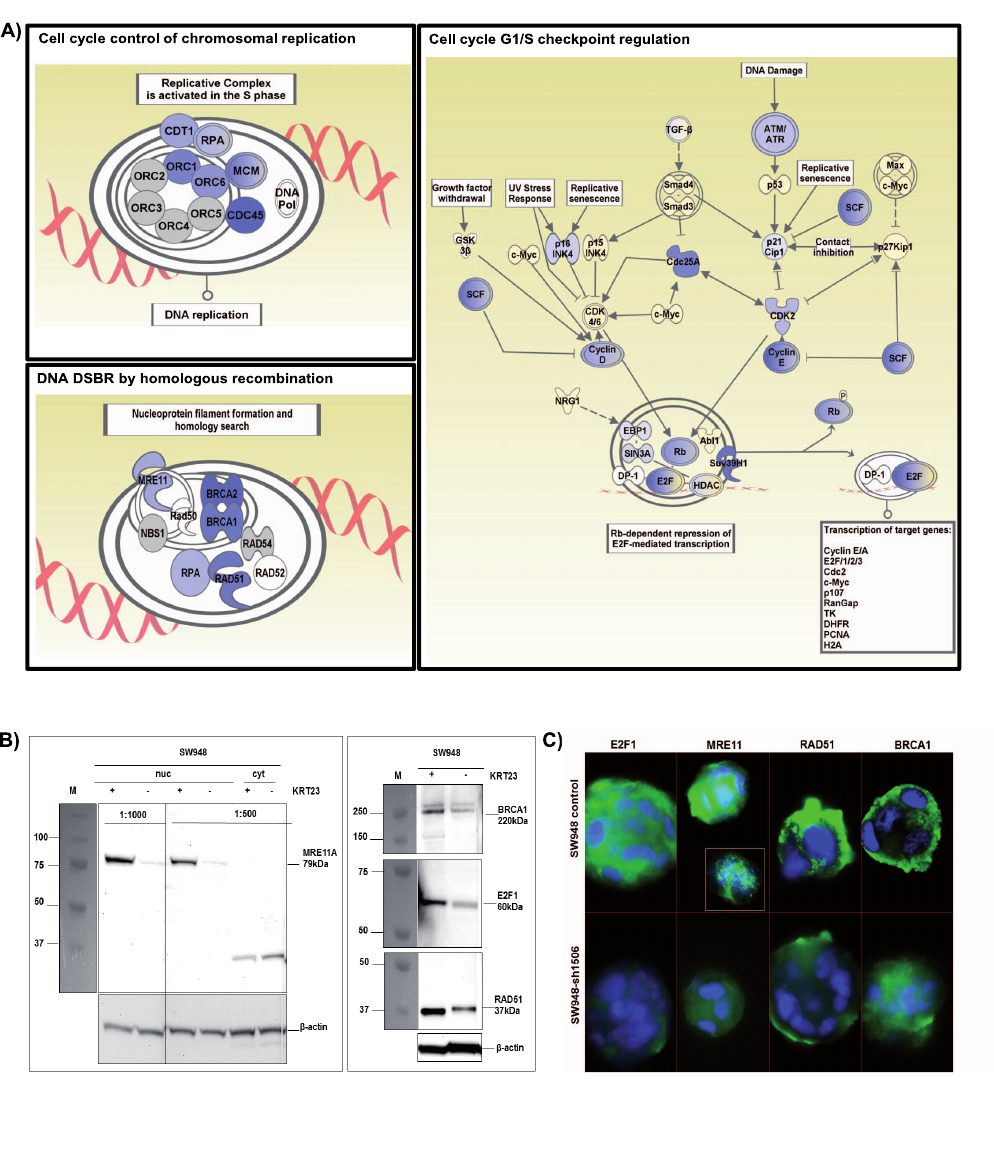
Figure 4. Ingenuity pathway analyses and protein expression. A) KRT23 knockdown affected main regulatory pathways, and decreased the expression of key molecules. Key molecules decreased upon KRT23 knockdown essential for the assembly of replication and repair complexes comprise E2F1, BRCA1, BRCA2, RAD51, MRE11A and RPA. blue=decreased, yellow=increased transcript expression. B) Western blotting. MRE11A, E2F1, BRCA1 and RAD51 proteins were markedly decreased in KRT23 depleted SW948-sh1506 cells compared to control cells. 20 m g nuclear (nuc) or cytoplasmic extract (cyt) was loaded. Anti-MRE11A antibody 1:1000 dilution (nuclear extracts), 1:500 dilution (nuclear and cytoplasmic extracts). Marker All Blue BioRad; C) Immunofluorescence staining of SW948-ctrl and SW948-sh1506 cells also showed that KRT23 knockdown resulted in a decreased expression of E2F1, MRE11A, RAD51 and BRCA1.